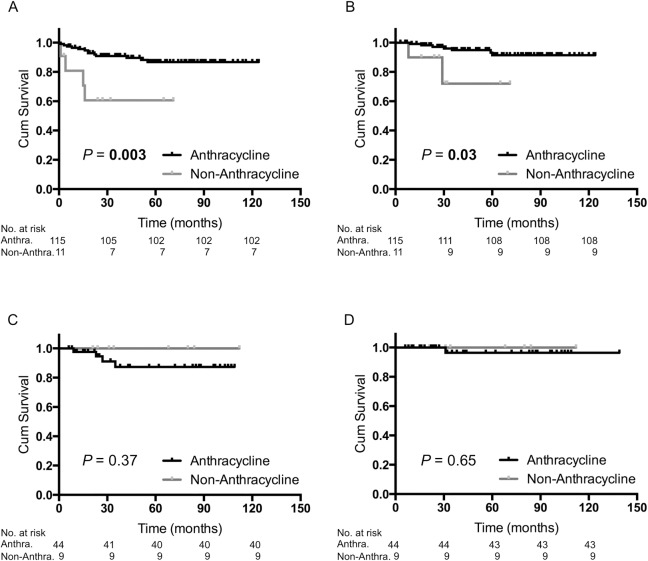
Kaplan–Meier analysis of patients who received anthracycline-based adjuvant chemotherapy versus non-anthracycline-based adjuvant chemotherapy.(A) Recurrence-free survival (RFS) of BRCAness tumors (n = 126). (B) Overall survival (OS) of BRCAness tumors (n = 126). (C) RFS of non-BRCAness tumors (n = 53). (D) OS of non-BRCAness tumors (n = 53). Anthracycline or Anthra, anthracycline-based adjuvant chemotherapy; Non-Anthracycline or Non-Anthra, non-anthracycline-based adjuvant chemotherapy.